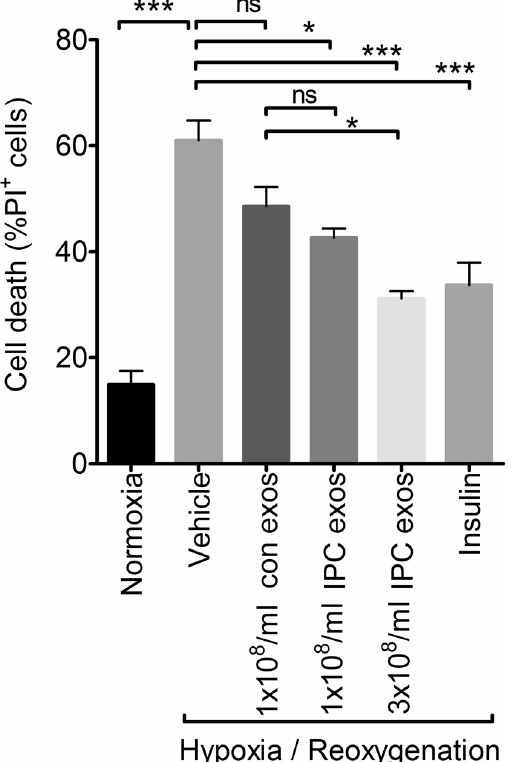
Figure 5. The effect of ischaemic preconditioning on protection by endothelial exosomes. Cardiomyocytes were pre-treated with the indicated concentration of exosomes from control HUVEC (con exos) or those that had been subject to a preconditioning stimulus (IPC exos), before analysis of cell death after H/R. Insulin pre- treatment was used as a positive control for cardioprotection. (N = 3; * P < 0.05, *** P <